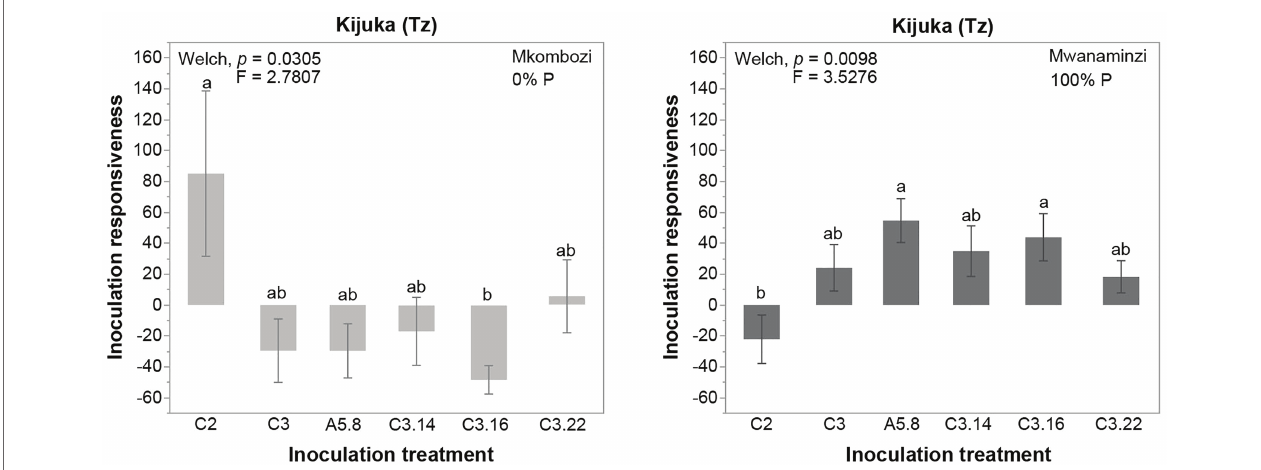
FIGURE 5 | Responsiveness of Mkombozi and Mwanaminzi varieties to inoculation with six R. irregularis inoculation treatments and at three levels of P fertilization. Error bars represent ±SE. Means with different letters are significantly different at p < 0.05 according to a Games-Howell post hoc test. Tz, Tanzania. Inoculation responsiveness was calculated by comparing inoculated plants to non-inoculated